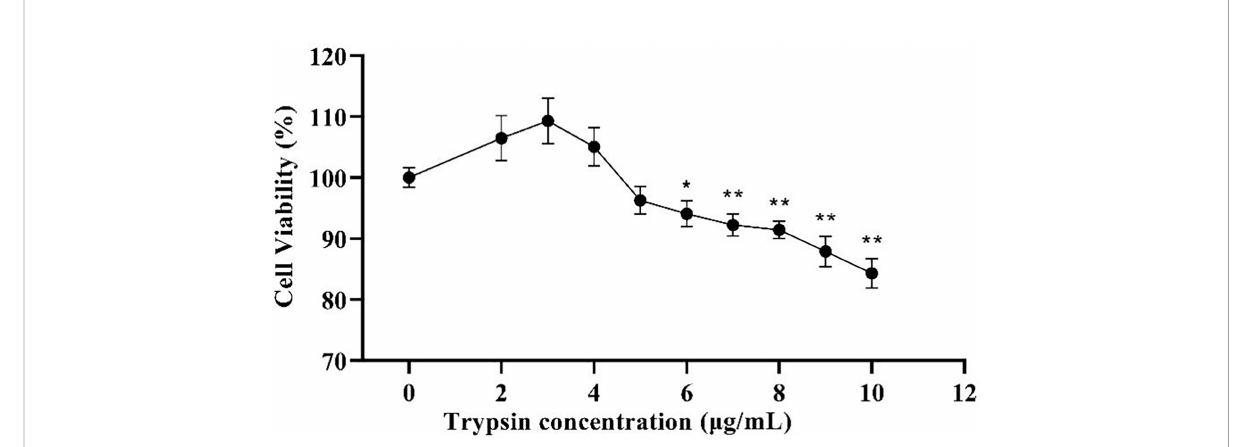
FIGURE 1 Effects of different trypsin concentrations on the viability of ST cells. * indicates that the difference is signi fi cant ( P < 0.05) compared with the group added with 0 m g/mL trypsin, ** indicates that the difference is extremely signi fi cant ( P <0.01), and no indication indicates that the difference is not signi fi cant ( P > 0.05), n=6.